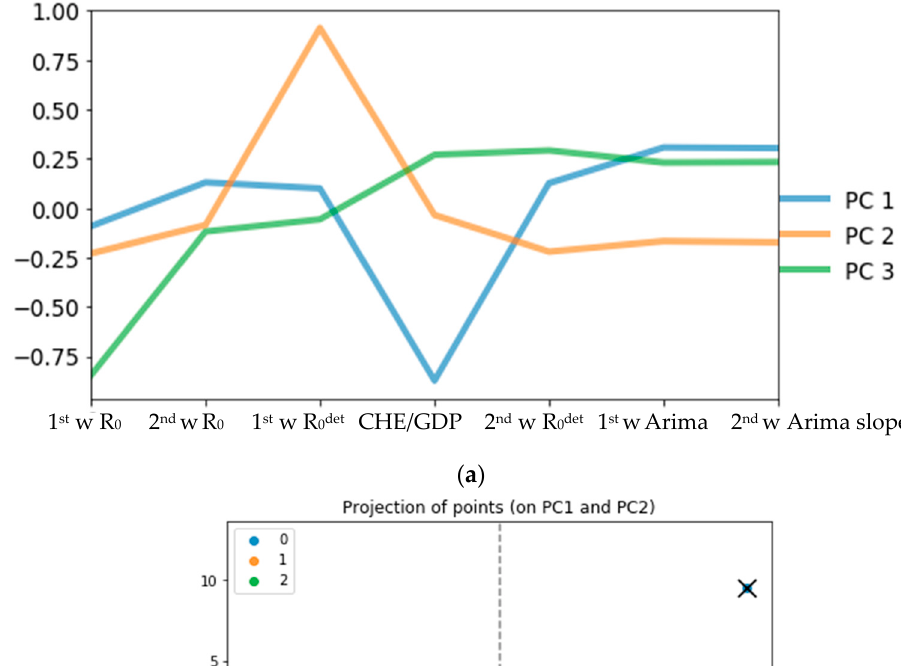
Figure 10. ( a ) Boxplots of the clusters corresponding to the hierarchical clustering. Visualizations of ( b ) more “developing” (in red with some notable exceptions such as the Czech Republic and Germany) and ( c ) more “developed” (in green and partially in orange) countries parts of the hierarchy tree.